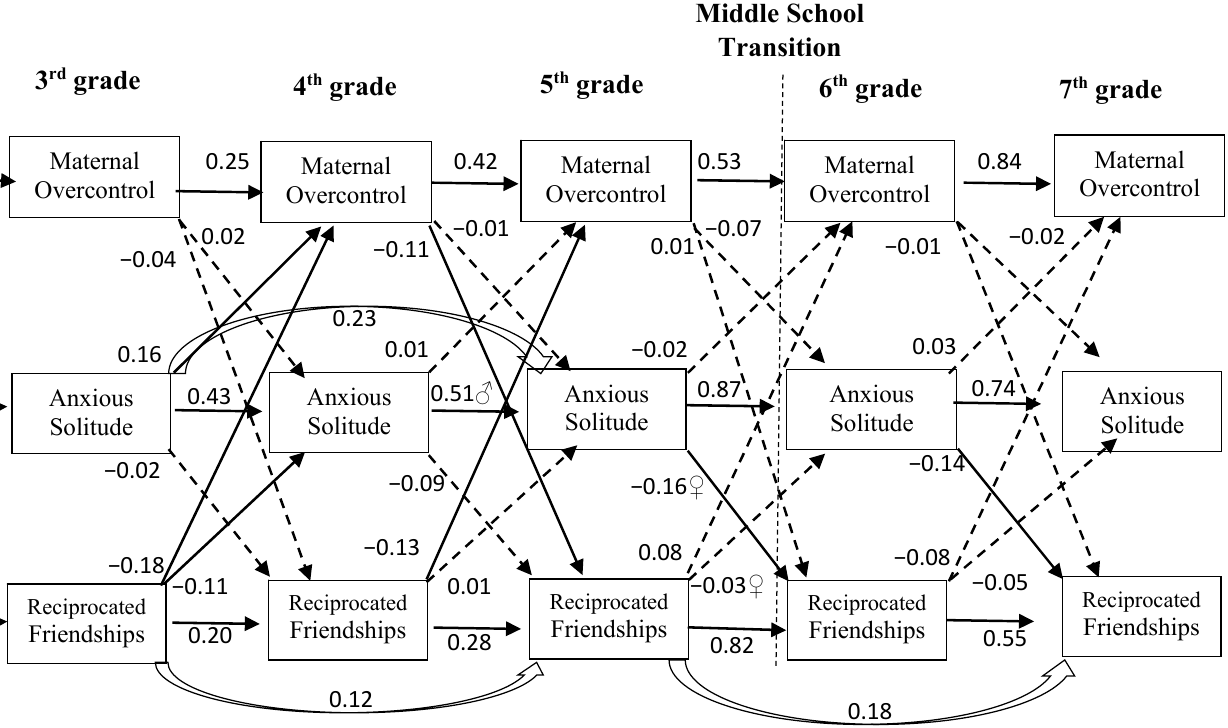
Figure 1. Autoregressive cross-lagged panel analysis of peer-reported anxious solitude and number of reciprocated friendships, and youth-reported maternal overcontrol from third through seventh grade. n = 230. χ 2 (60) = 89.69, p = 0.008; NC = 1.50; CFI = 0.96; RMSEA = 0.05, p - close = 0.60. Solid and outlined arrows indicated significant paths ( p < 0.01 or p < 0.05). Dashed arrows indicated non-significant paths. Path coefficients are standardized. Gender moderation: ♂ = path stronger for boys than girls, ♀ = negative path for girls significantly differs from path for boys (gender-specific coefficients appear in the text). Assessments occurred in the fall of third grade and the spring of each subsequent grade.